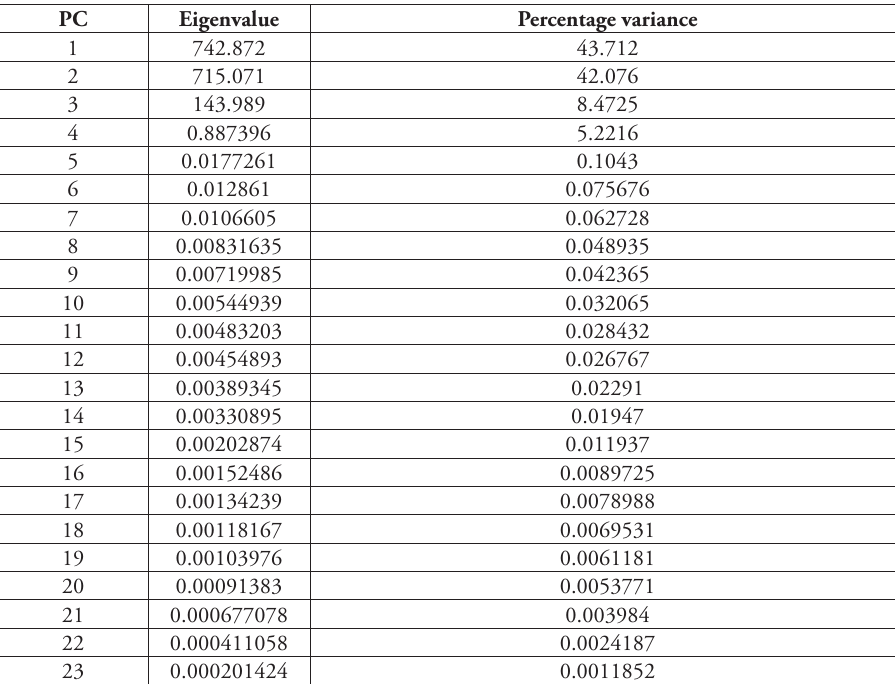
Table 2. Eigenvalue for principal components (PC) between Hyphessobrycon klausanni sp. n., H. acaciae , H. mavro , H. metae and H. niger